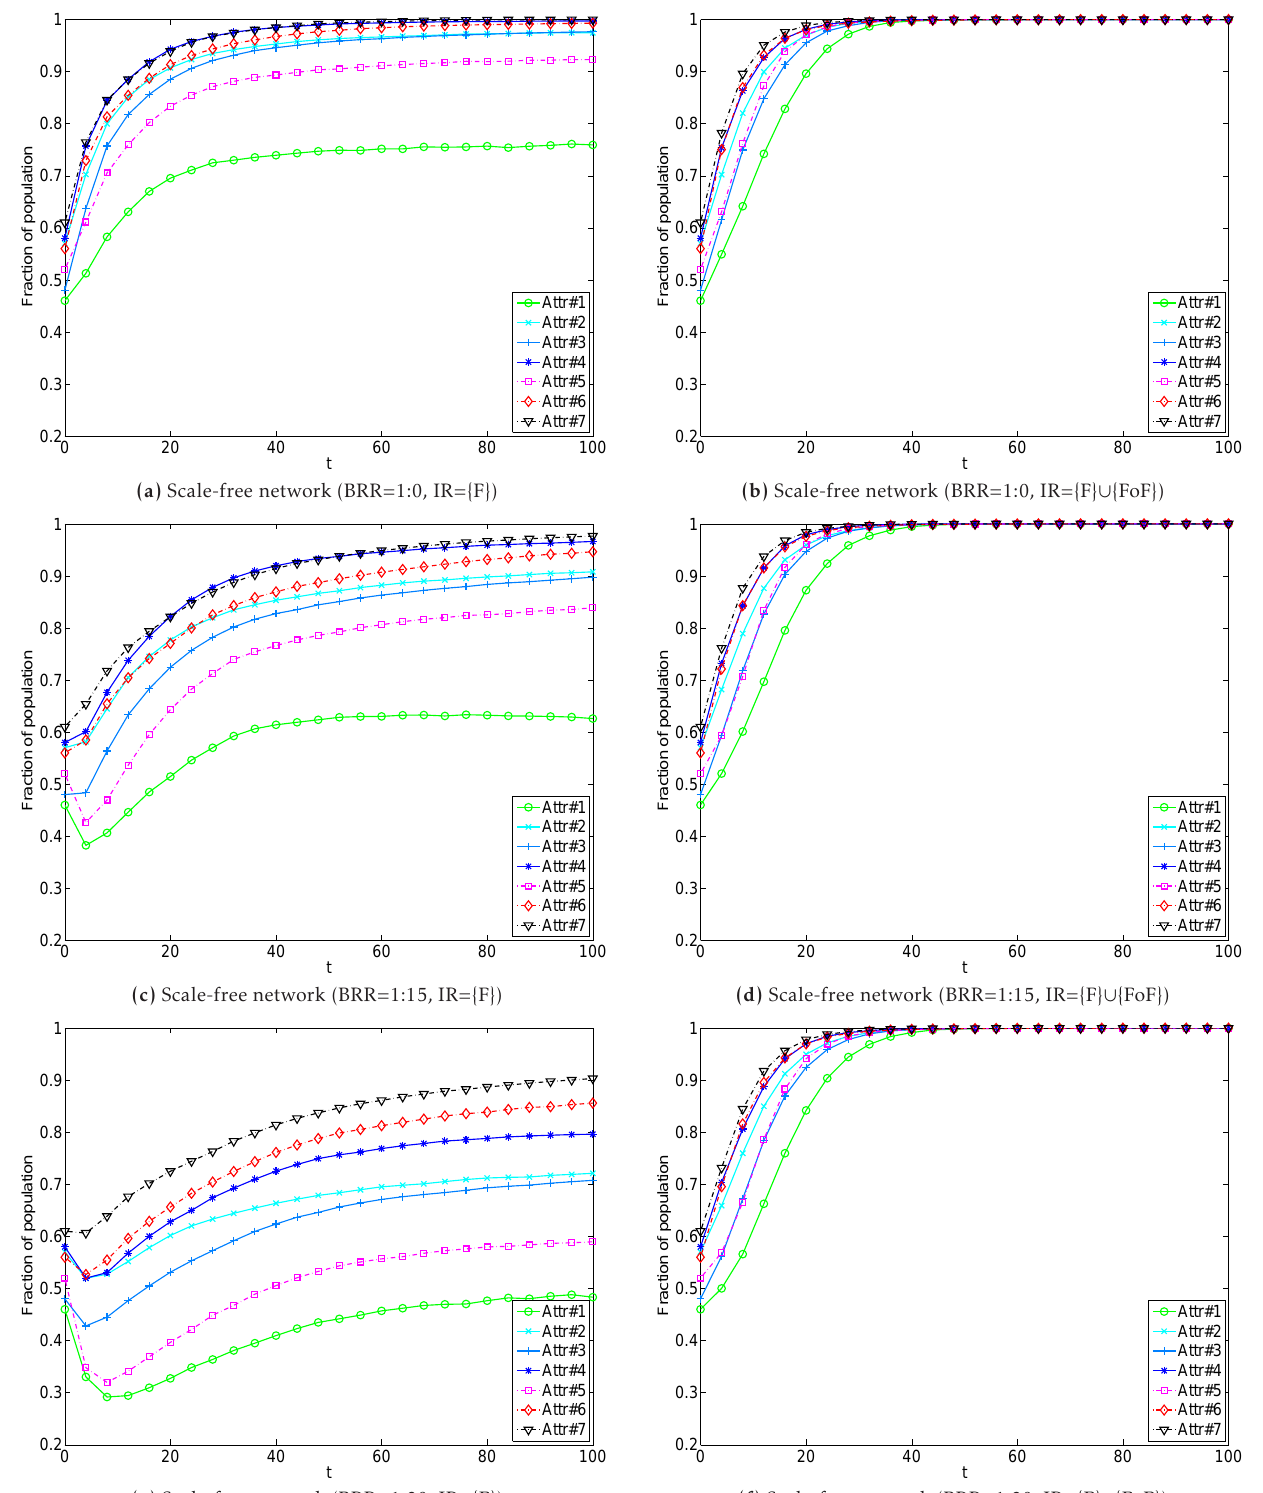
Figure 8. Attribute dynamics for the weighted evolutionary game in scale-free network. The figures in left column correspond to applying Friends as the influential range of the utility